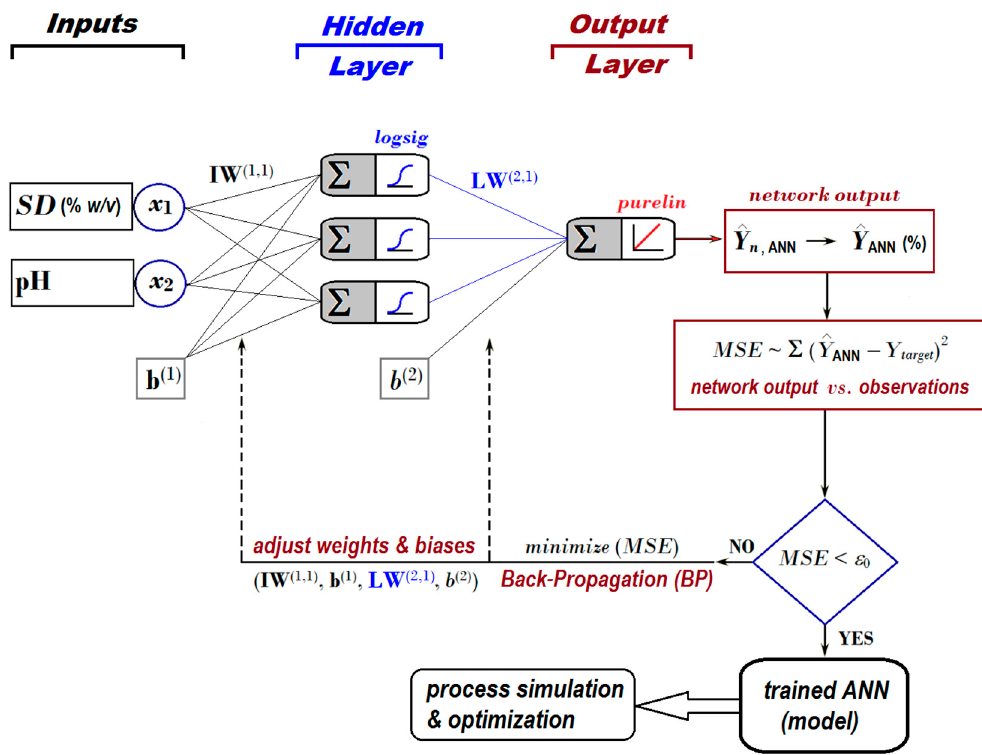
Figure 4. Feed-forward ANN architecture [2:3:1] developed to predict the removal efficiency of ni- trite ions from aqueous solutions by using the adsorption-ultrafiltration hybrid process.